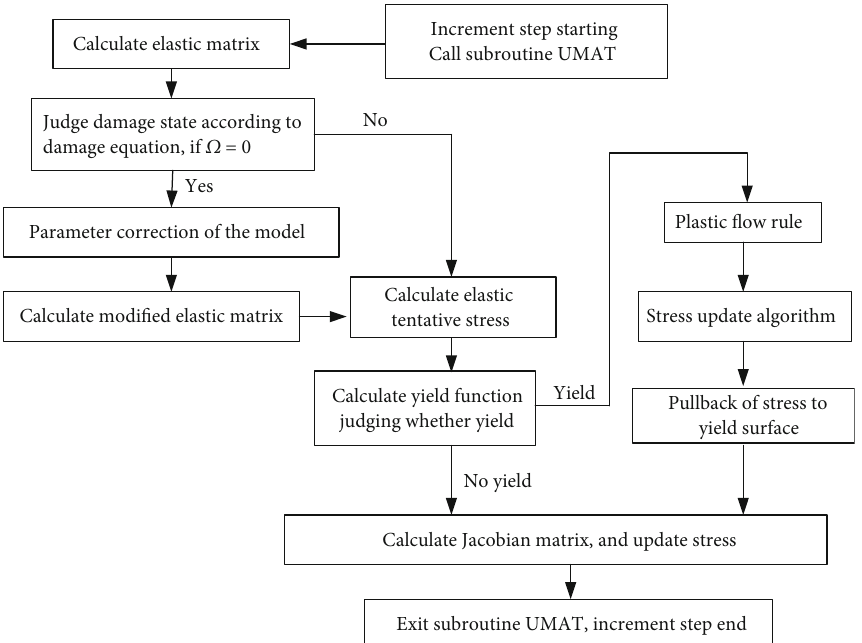
Figure 5: Flow chart of the UMAT subroutine.